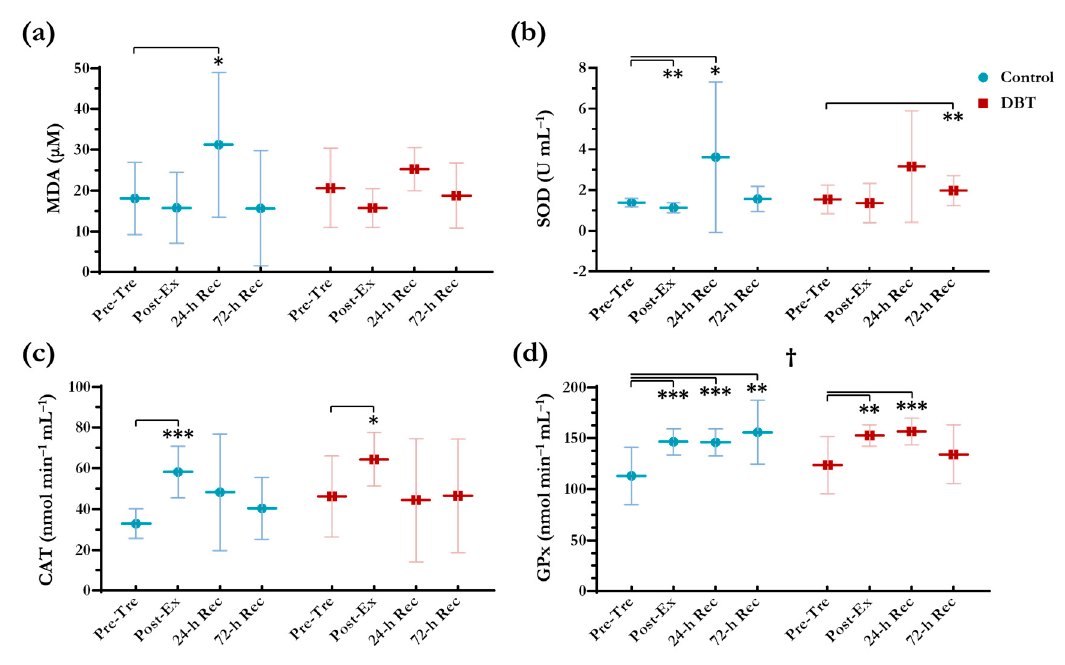
Figure 5. Changes in serum levels of ( a ) malondialdehyde (MDA), ( b ) superoxide dismutase (SOD), ( c ) catalase (CAT), and plasma levels of ( d ) glutathione peroxidase (GPx). † Significant group × time effect ( p < 0.05) analysed using two-way repeated measures ANOVA. * p < 0.050, ** p < 0.010, *** p < 0.001 as compared with Pre-Tre in each independent group using paired t ‐ test.